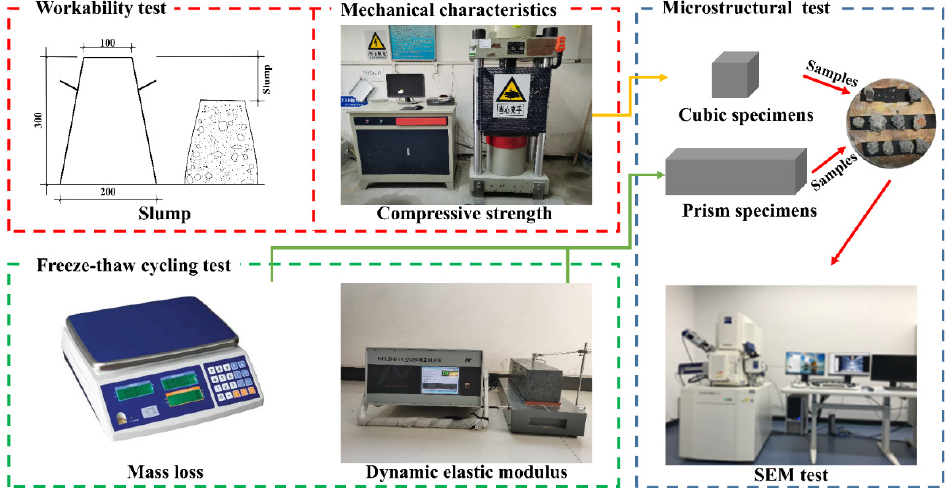
Figure 3. Experimental